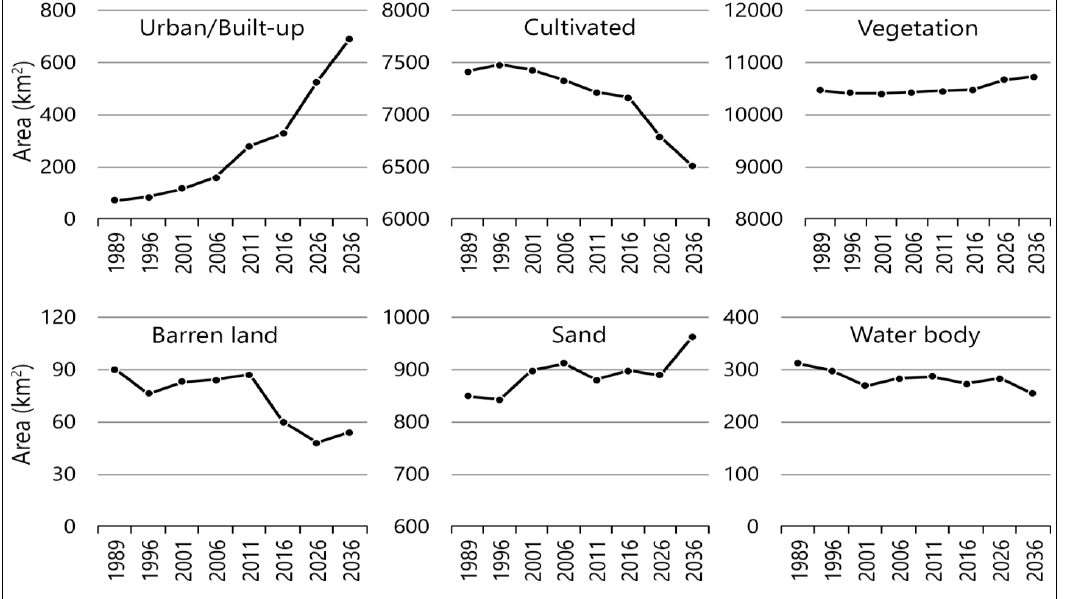
Figure 2. LULC transition in different classes from 1989 to 2036. The LULC transitions from 2016 and 2036 were predicted.